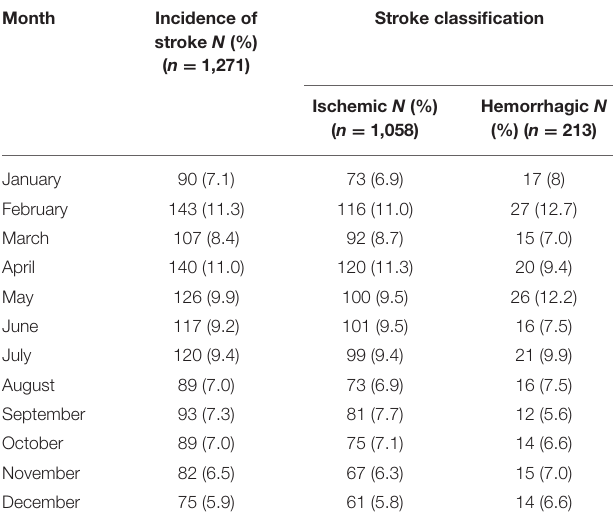
TABLE 4 | The incidence of ischemic and hemorrhagic stroke in Riyadh, Saudi Arabia, by months between 2016 and